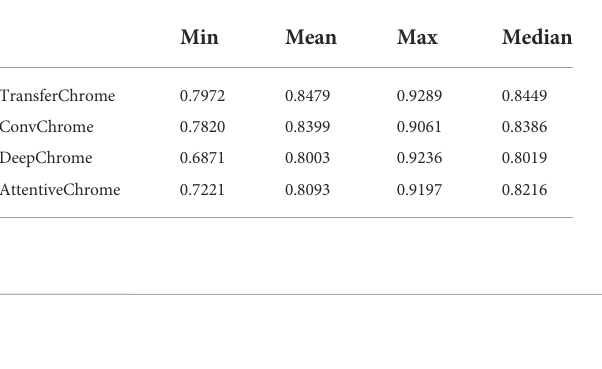
TABLE 2 The minimum, mean, maximum, and median of the AUC scores of single cell line gene expression prediction of the models on 56 cell lines.